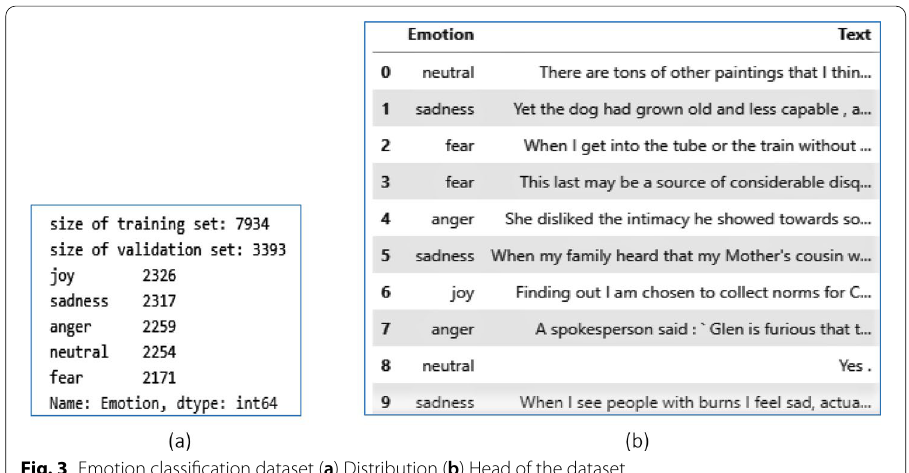
Fig. 3 Emotion classification dataset ( a ) Distribution ( b ) Head of the